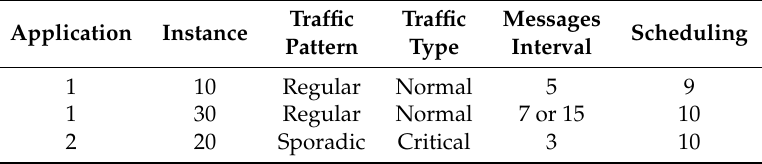
Table 6. Scheduling for DYNASTI for the Adaptive Interval